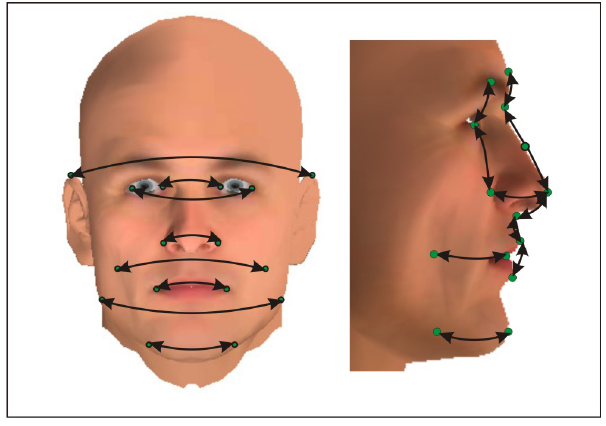
Figure 4. Some anthropometric measurements of the base model.